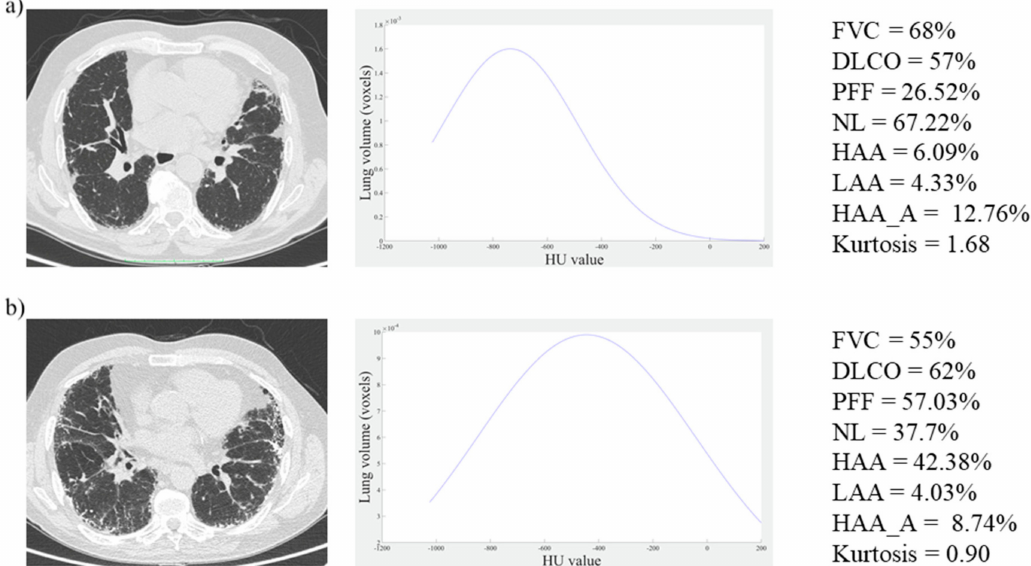
Figure 2. Two representative clinical cases: HRCT images (left), HRCT lung histograms (centre), pulmonary function tests and quantitative parameters (right): ( a ) Patient a ff ected by moderate idiopathic pulmonary fibrosis (IPF), ( b ) Patient with more severe evidence of IPF. Forced vital capacity (FVC), di ff usion capacity for carbon monoxide (DLCO), PFF, NL, HAA, LAA, and HAA_A parameters are expressed in percentage values while kurtosis is expressed in absolute